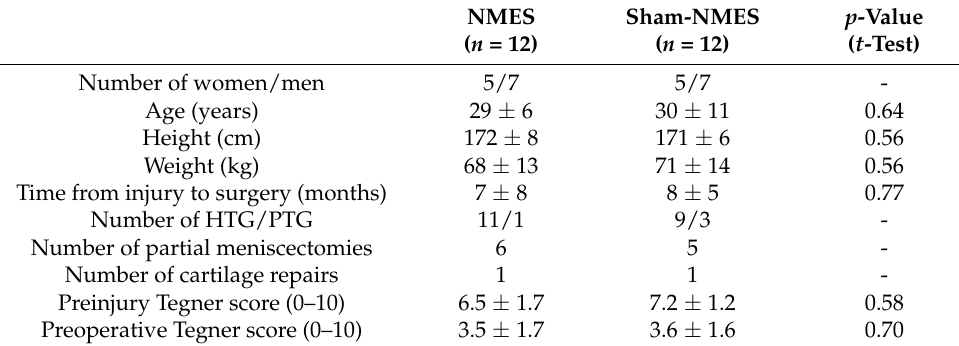
Figure 2. Overview of the experimental protocol. Table 1. Patient characteristics by